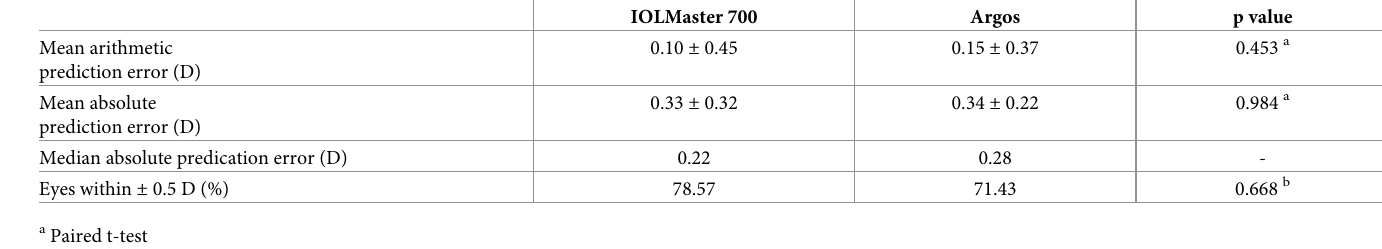
Table 3. Postoperative arithmetic and absolute refractive errors of the two SS-OCT devices (n = 14) in eyes which AXL was not measured by the PCI device.